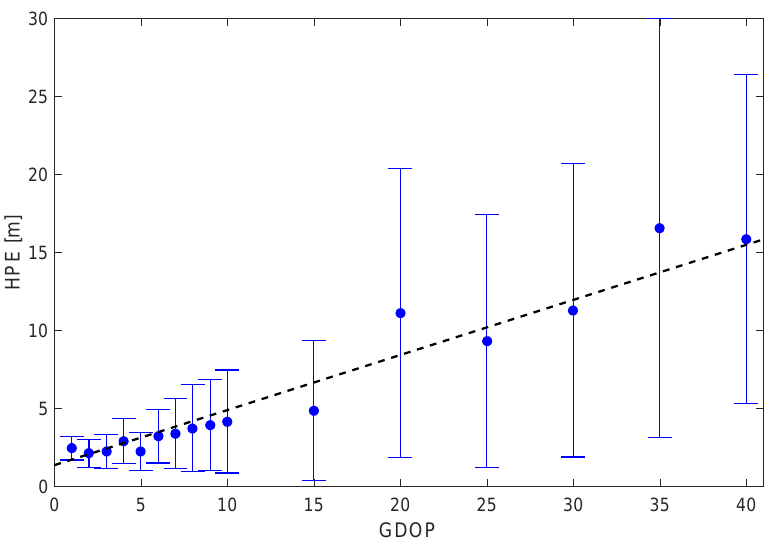
Figure 10. Mean HPE versus GDOP for all three antennas together. Error bars mark the 1 σ